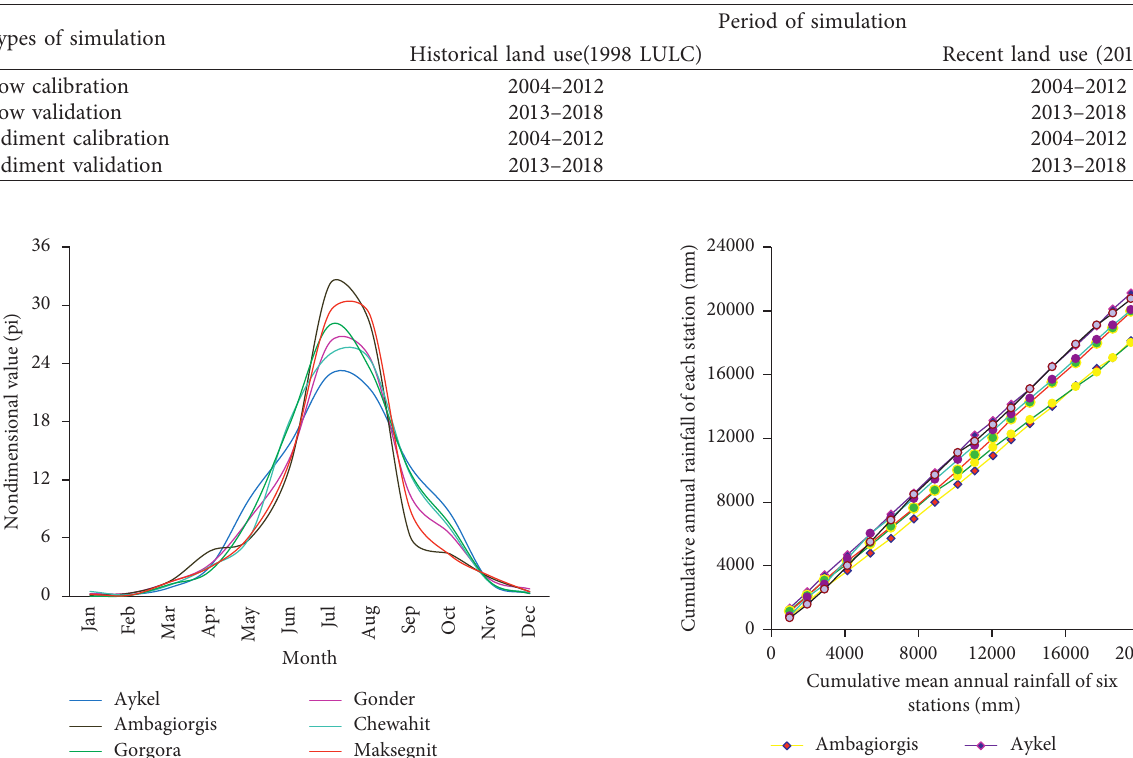
Table 5: Calibration and validation periods for flow and